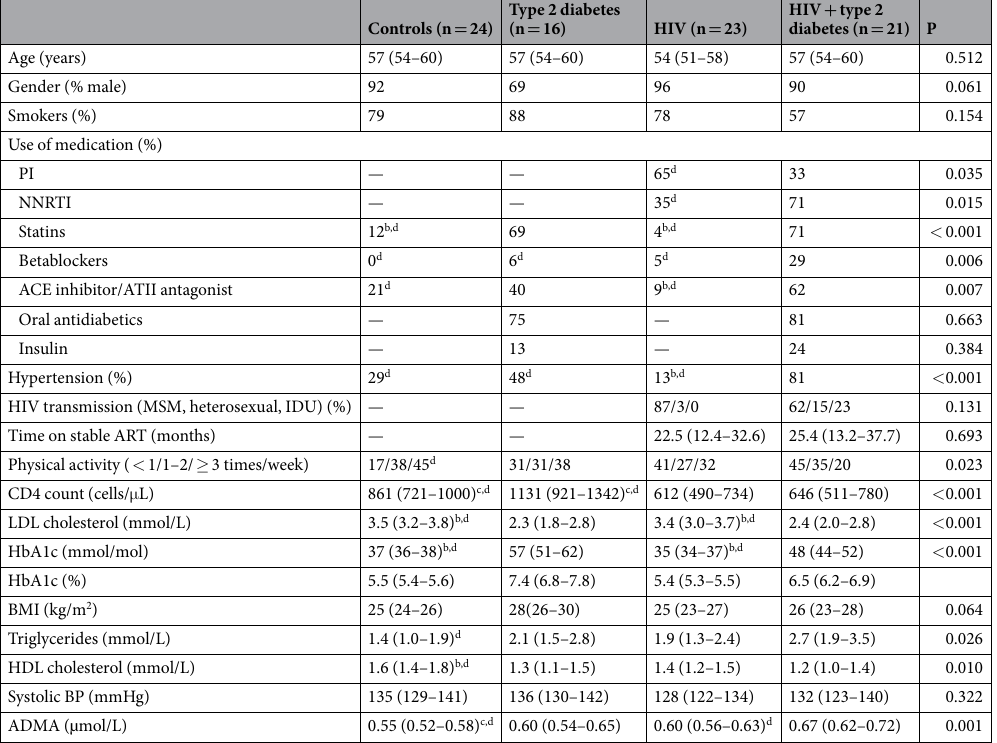
Table 1. Demographic and biochemical characteristics of the study population. P-value refers to one-way ANOVA for continuous data and Chi-Square or Fisher’s exact test for categorical data. Results are given as % or mean and 95% CI. b,c,d Refers to t-test; b p < 0.05 vs. T2D, c p < 0.05 vs. HIV, d p < 0.05 vs. HIV + T2D.